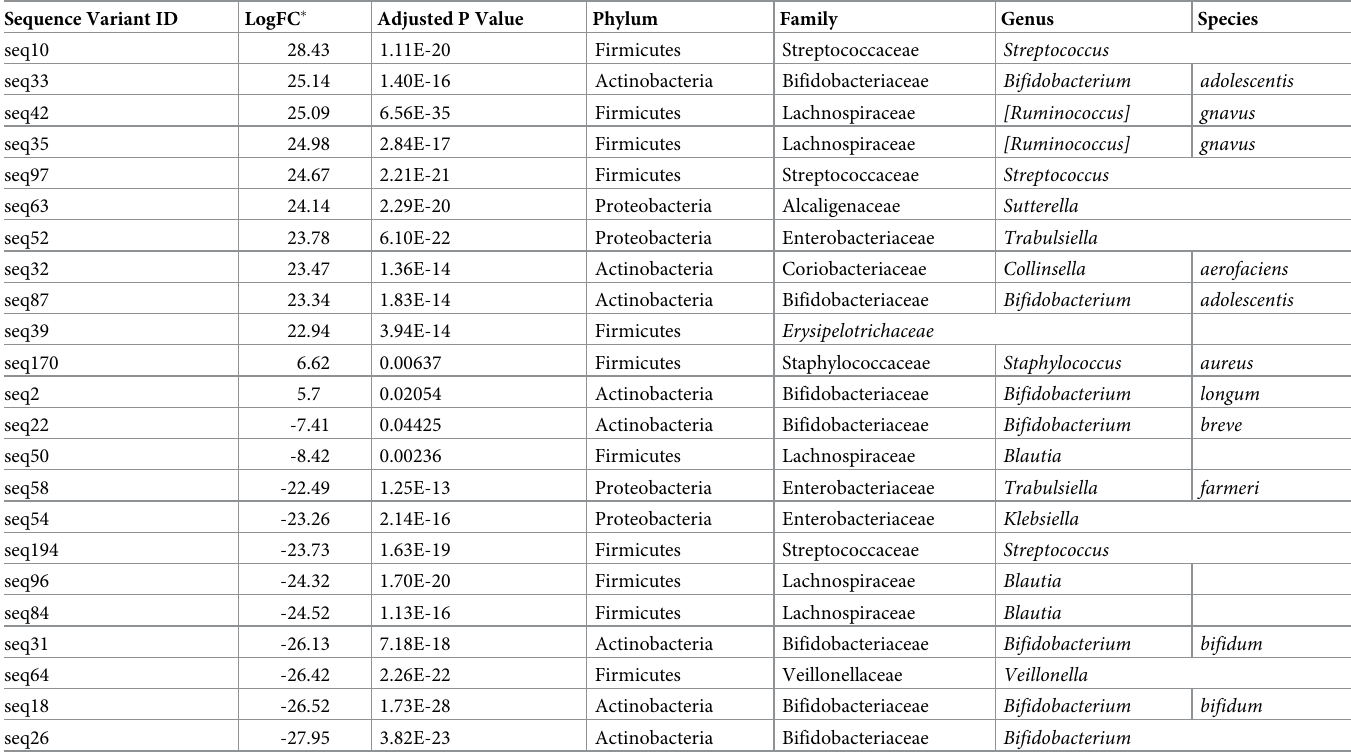
Table 2. Sequence variants with significant differential abundance between exclusive breastfed (EBF) and mixed fed (MF) samples (DESeq2; adjusted p < 0.05). Sequence Variant ID